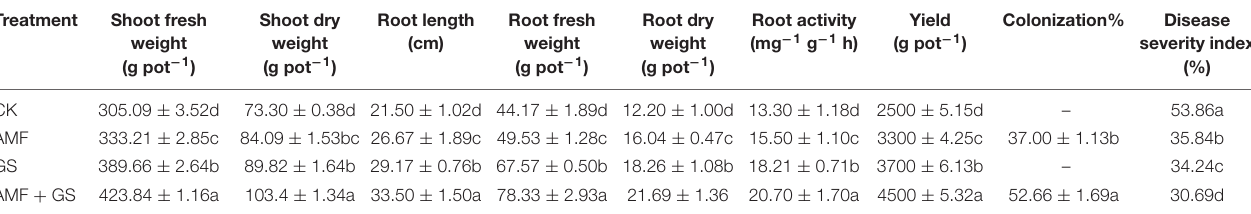
TABLE 1 | The effect of AMF inoculation and DRGS application on shoot fresh and weight, root length, root fresh and dry weight, yield, root AMF colonization%, and disease severity index.